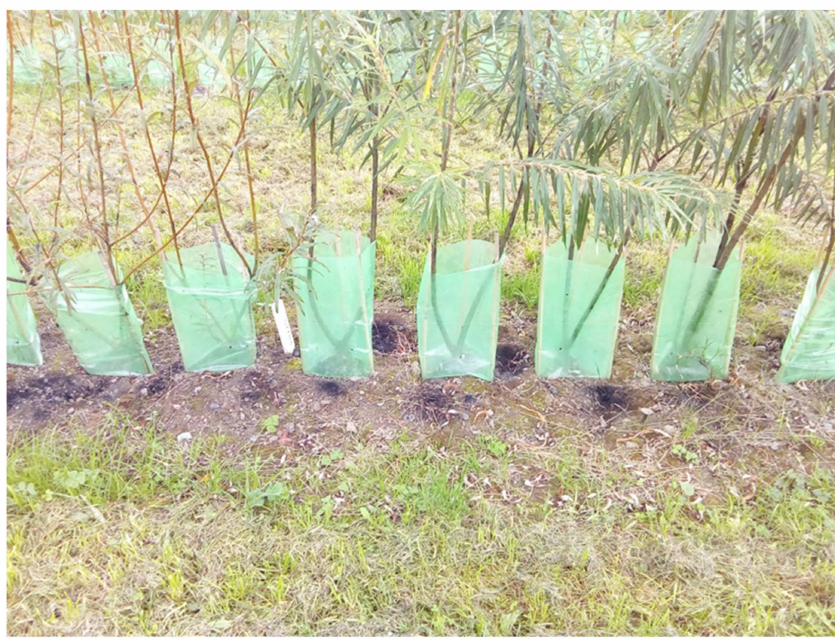
Figure 1. Black sooty mould spots under the canopy of willow